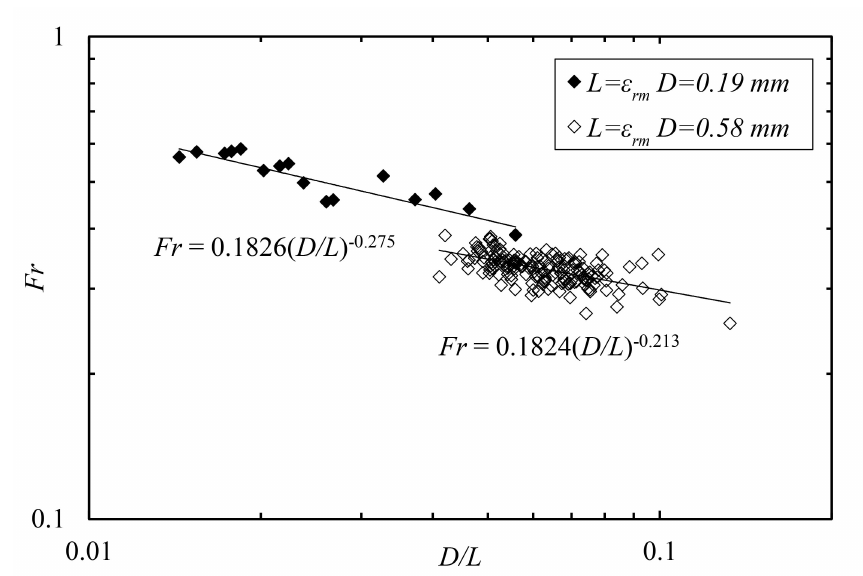
Figure 3. The dimensionless predictive formula of scour depth.